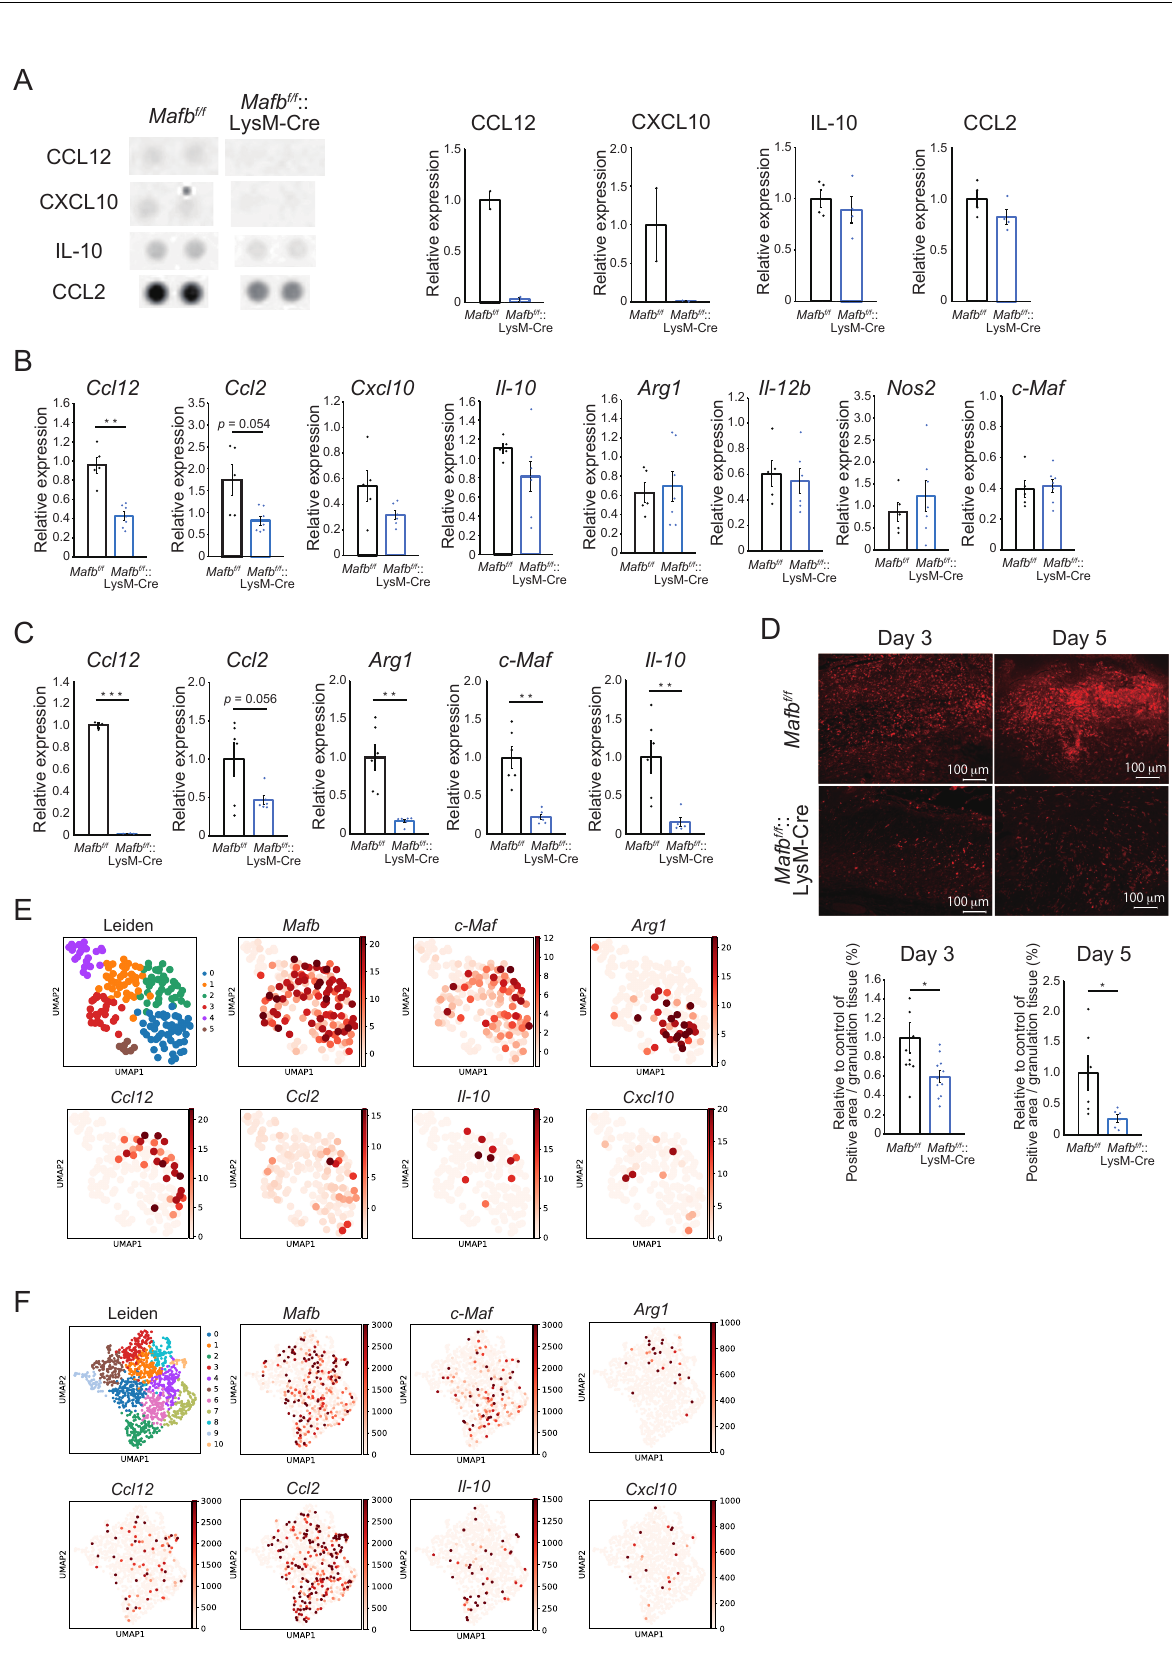
Figure 4. Expression levels of genes related to wound healing were decreased by Mafb deletion in macrophages. ( A ) Cytokine arrays were performed on the day 3 wound tissue. CCL12 and CXCL10 expression in Mafb f/f and Mafb f/f ::LysM-Cre mice was analyzed with a Proteome